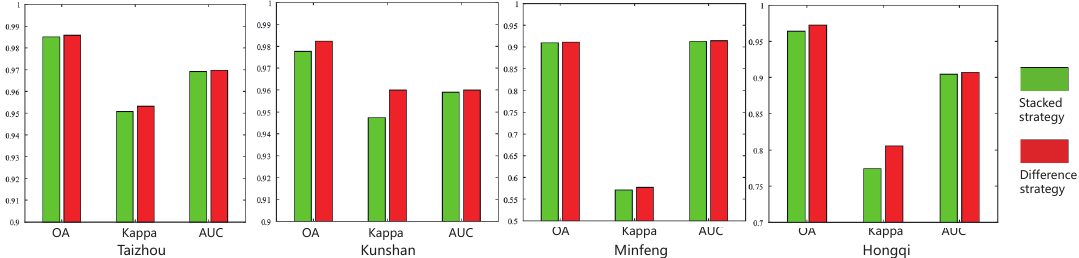
Figure 5. OA, Kappa and AUC values comparision of four different data sets. Green color denotes the stacked strategy based method and red color denotes our proposed SSJLN that uses the difference strategy.